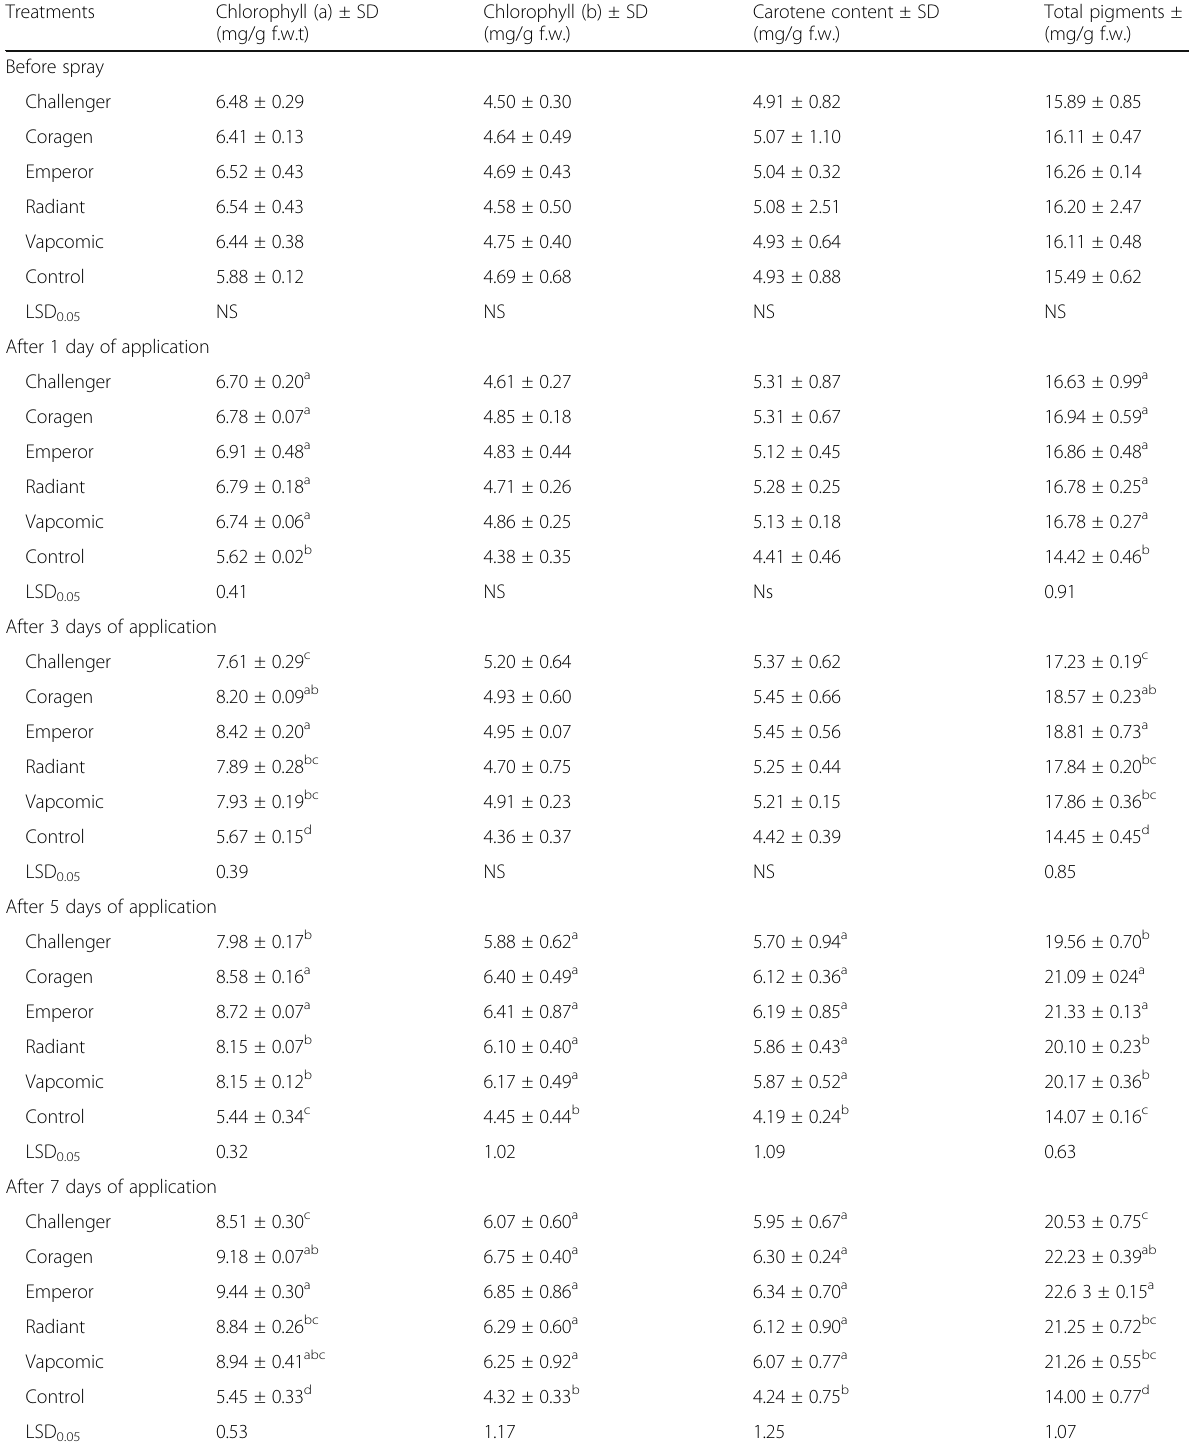
Table 8 Effect of the tested insecticides on chlorophyll a, b, carotene content, and total pigments of tomato leaves at different intervals of